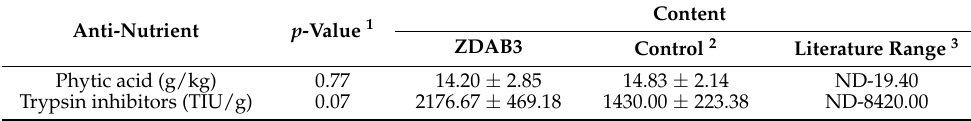
Table 8. Anti-nutrient values in maize